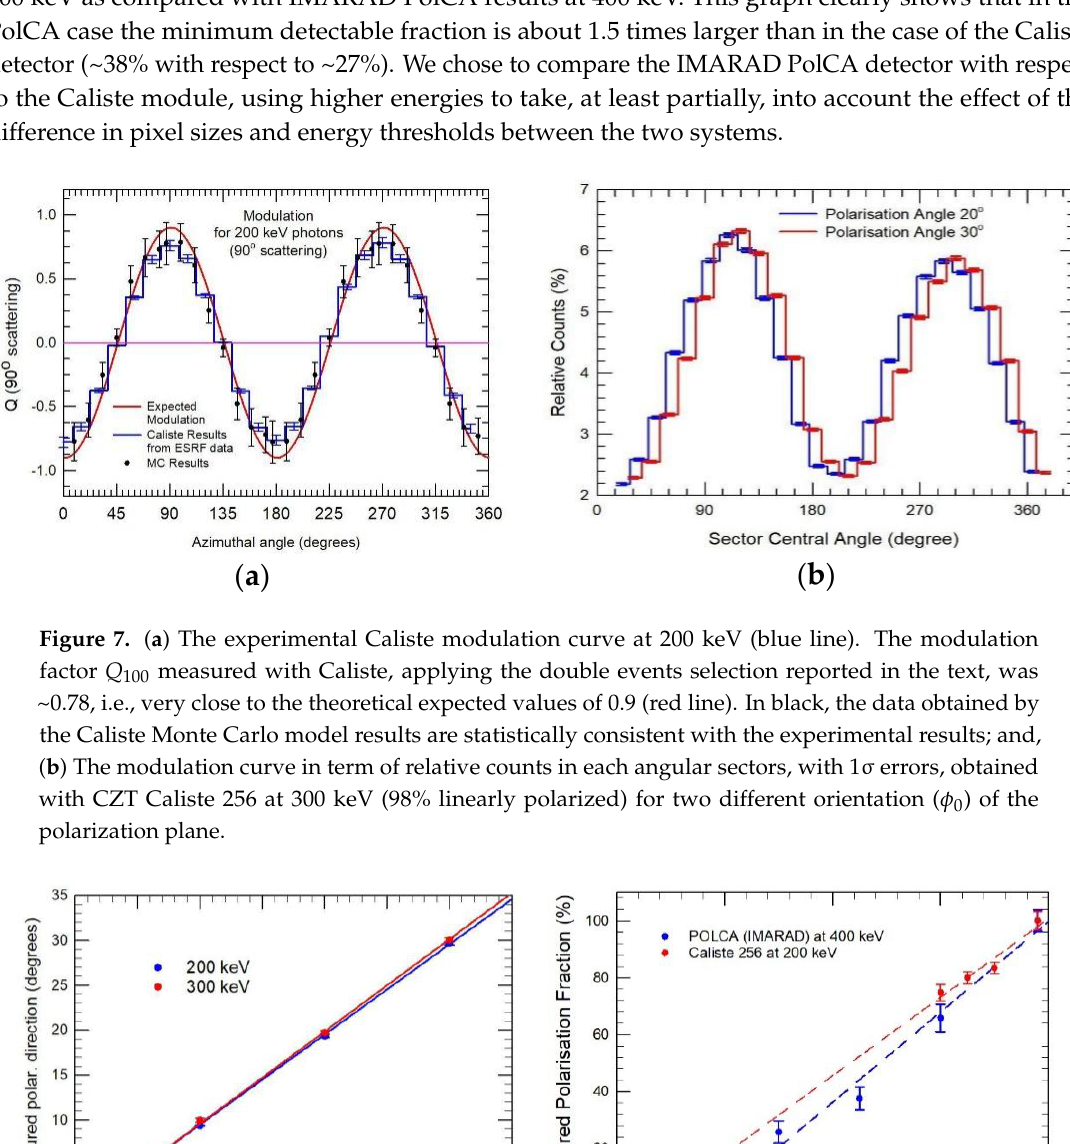
Figure 8. ( a ) The measured polarization plane direction versus the real beam polarization plane direction at two energies; and, ( b ) Comparison between the sensitivity to the beam polarization fraction evaluated from ESRF data for the PolCA (IMARAD) and the CZT Caliste 256 pixel detectors, respectively. The large difference between the two results is a confirmation of the modulation factor improvement achievable with a finest discretization (i.e., spatial resolution) coupled with fine spectroscopic performance. The larger size of pixels (2.5 vs ∼ 0.6 mm) and the higher energy threshold of the first detector with respect to the second one ( ∼ 30 keV vs. 3 keV), drastically affect both the mean scattering path length and the scattered events statistics, i.e., the effective modulation factor. These effects are more evident in the IMARAD PolCA detector for low energy. As shown, and, as expected, the Caliste 256 system is more efficient with respect to the IMARAD detector also in the reconstruction of the polarization fraction, allowing for measuring this parameter at least a factor of two better, i.e., Caliste can measure lower fraction of polarization with respect to the IMARAD detector.